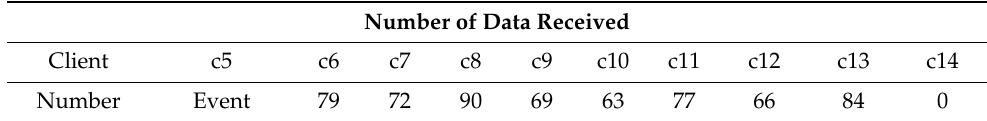
Table 4. Number of data received from clients.